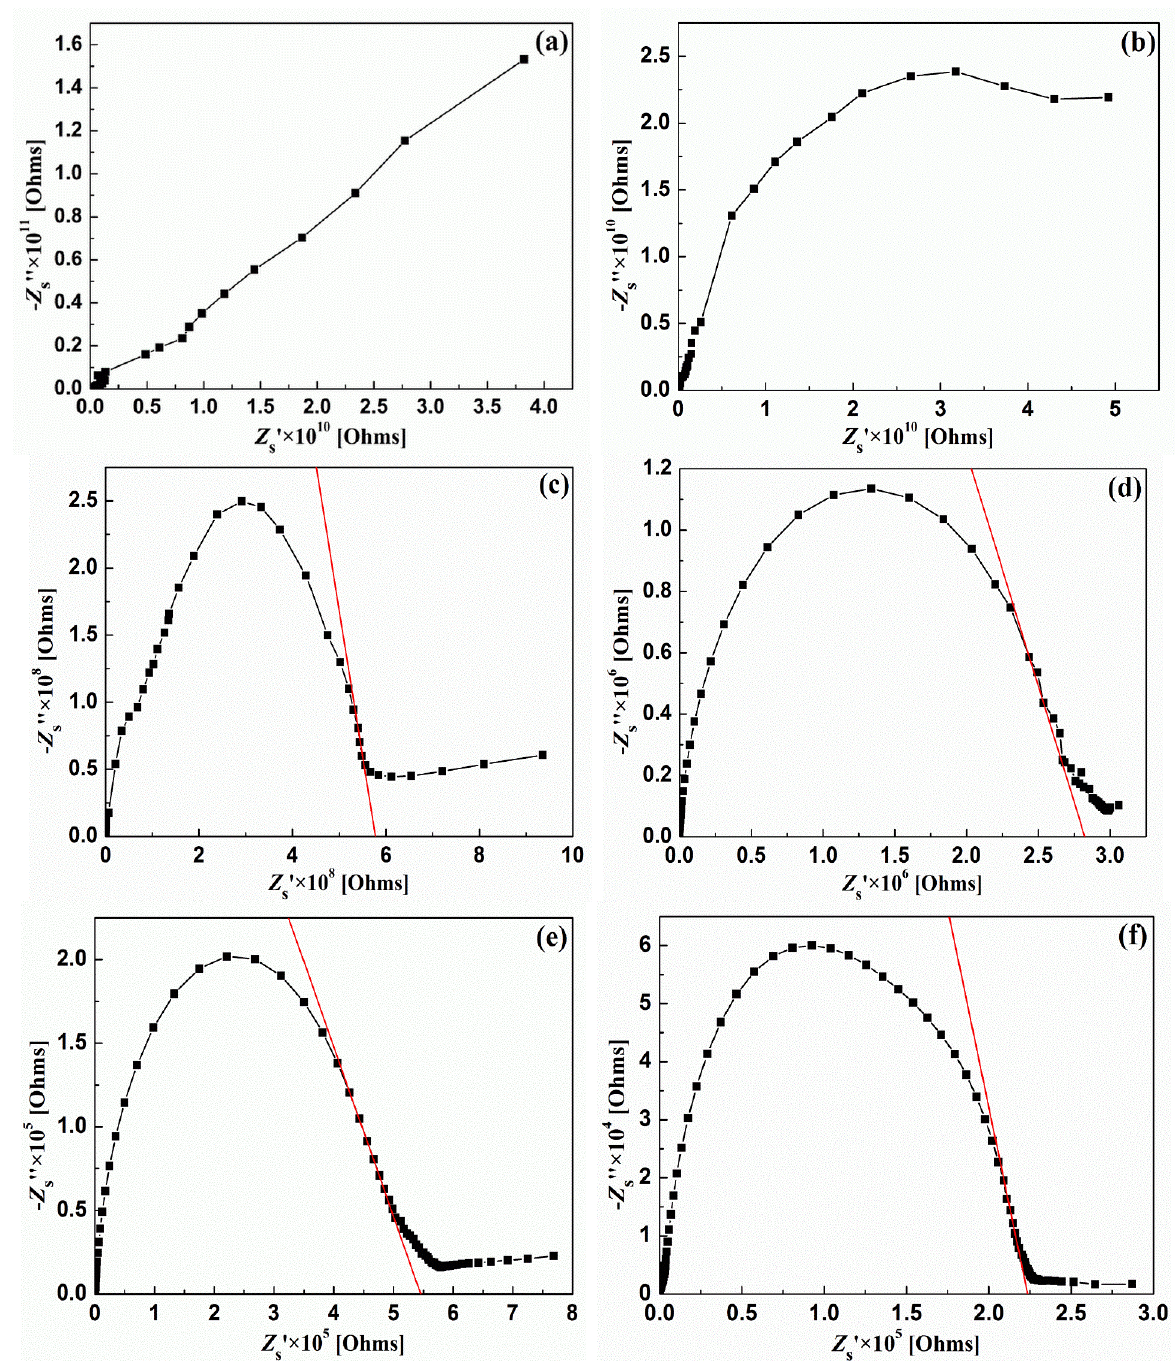
Figure 6. Complex impedance spectra of La 0.9 Sr 0.1 TiO 3+δ : ( a ) 100 °C; ( b ) 200 °C; ( c ) 300 °C; ( d ) 400 °C; ( e ) 500 °C; ( f ) 600